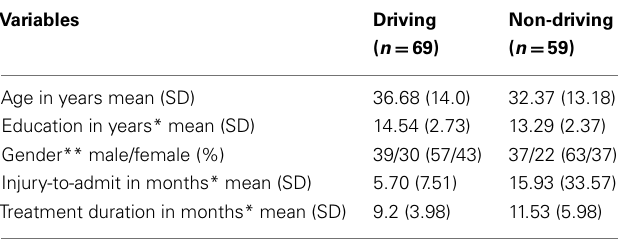
Table 2 | Demographic variables and driving status.